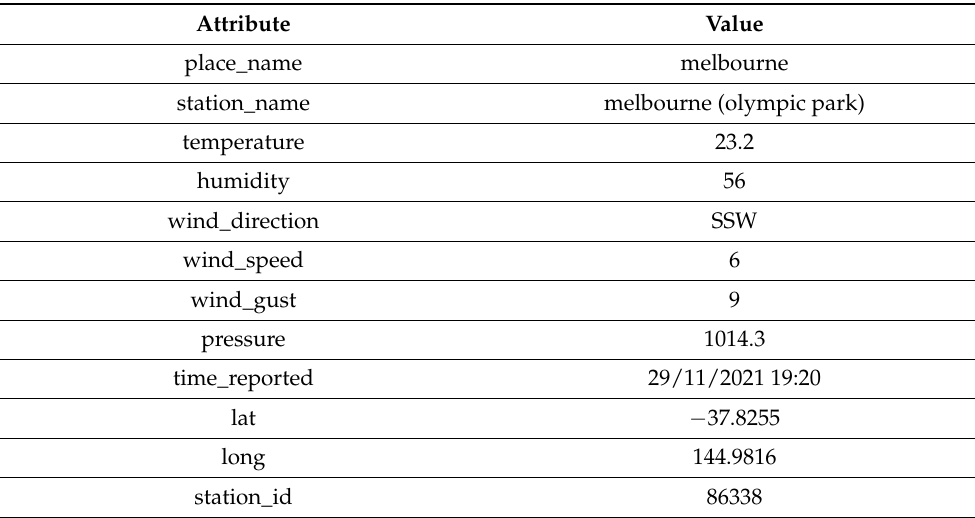
Table 2. Sample observation from the Melbourne Olympic Park weather station